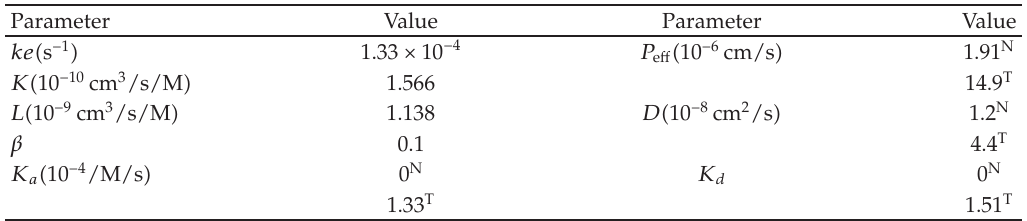
Table 1: Baseline parameter values used for drug delivery simulations (cid:5) 19–21 (cid:6) . Parameter values with superscripts “T,” “N” represent the internal and external parameters of the tumor.